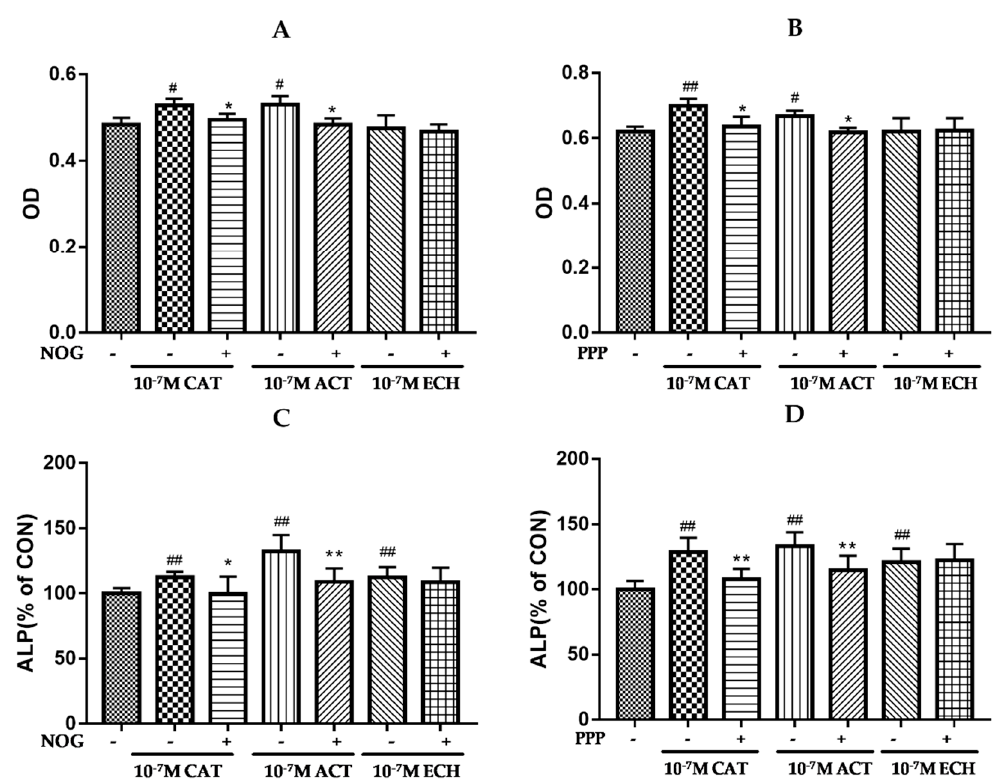
Figure 7. Noggin (NOG) and picropodophyllin (PPP) counteract the effects of CAT, ACT, and ECH on MC3T3- E1 cells. MC3T3-E1 cells were treated with CAT, ACT, and ECH at a concentration of 10 − 7 M, or combined with NOG (200 ng/mL) or PPP (2 × 10 − 7 M) for 48 h. ( A,B ) Cell viability was assayed using a CCK-8 kit ( n = 6); ( C,D )